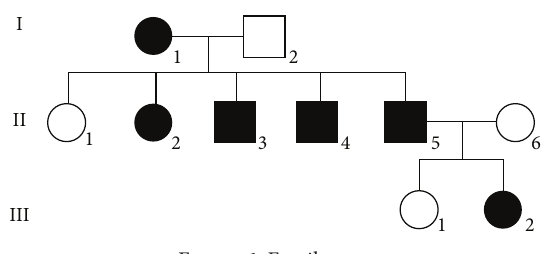
Figure 1: Family